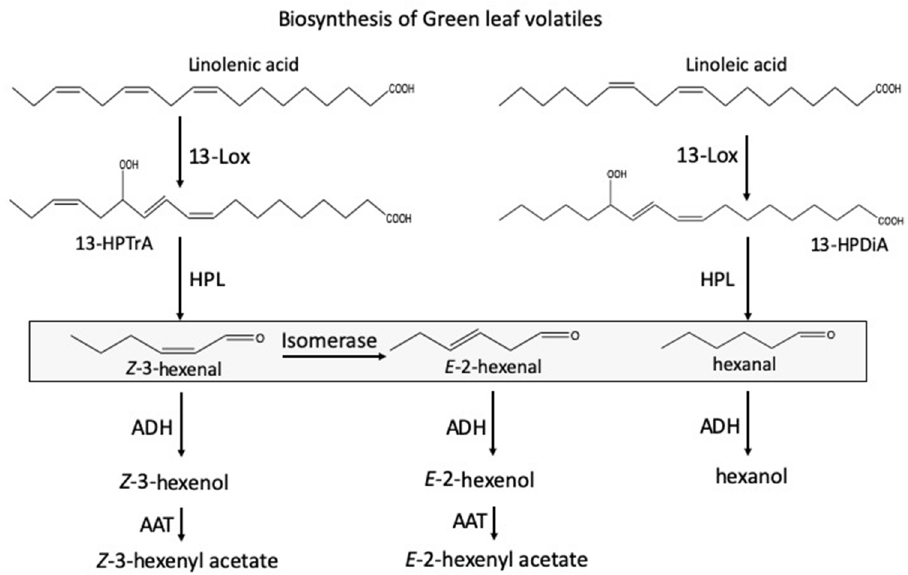
Figure 1. Biosynthetic pathways leading to green leaf volatile production in plants. A 13-lipoxygenase (13-LOX) catalyzes the addition of molecular oxygen at position 13 in linolenic acid and linoleic acid to form 13-hydroperoxy octadecatrienoic and 13-hydroperoxy octadecadienoic acid (13-HPTrA and 13-HPDiA). These oxygenated fatty acids are then converted to ( Z )-3-hexenal and hexanal, as well as 9-( Z )-traumatin, by hydroperoxide lyase (HPL). An isomerase converts ( Z )-3-hexenal into ( E )-2-hexenal. ( Z )-3-Hexenal and ( E )-2-hexenal can be reduced to ( Z )-3-hexenol and ( E )-2-hexenol, respectively, by alcohol dehydrogenase(s) (ADH). ( Z )-3-Hexenol and ( E )-2-hexenyl acetate can further be converted to ( Z )-3-hexenyl acetate and ( E )-2-hexenyl acetate by alcohol acyltransferase(s) (AAT). Boxed compounds are those produced mainly by damaged plant tissue.